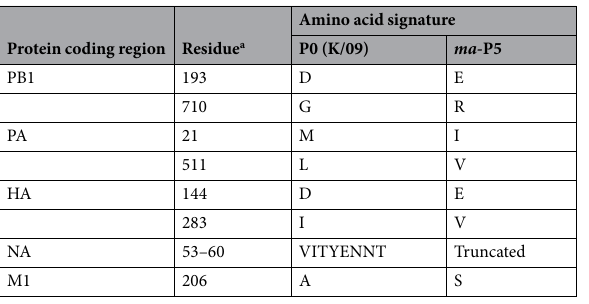
Table 2. Amino acid changes between the K/09 and ma -P5 viruses. a Based on K/09